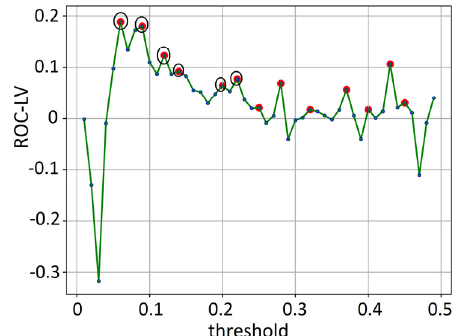
Figure 2. ROC-LV graph. Threshold values: 0.06, 0.09, 0.12, 0.14, 0.20, 0.22 are selected as segmentation